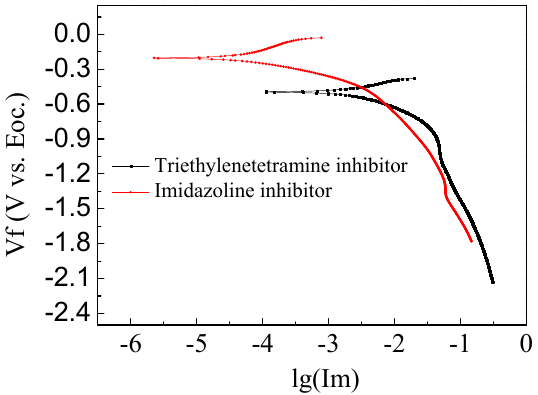
Figure 4. Cathodic polarization curve of stressed steel bar in corrosion inhibitor.